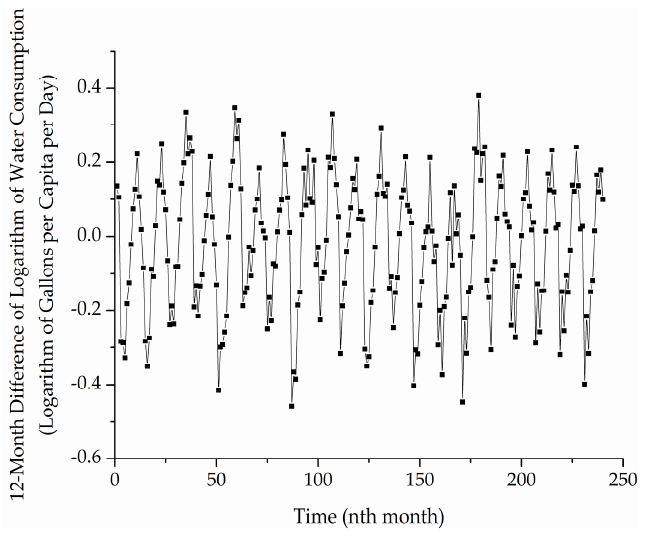
Figure 5. The 12th difference of the natural logarithm of water consumption in Las Vegas from 1990 to 2010.